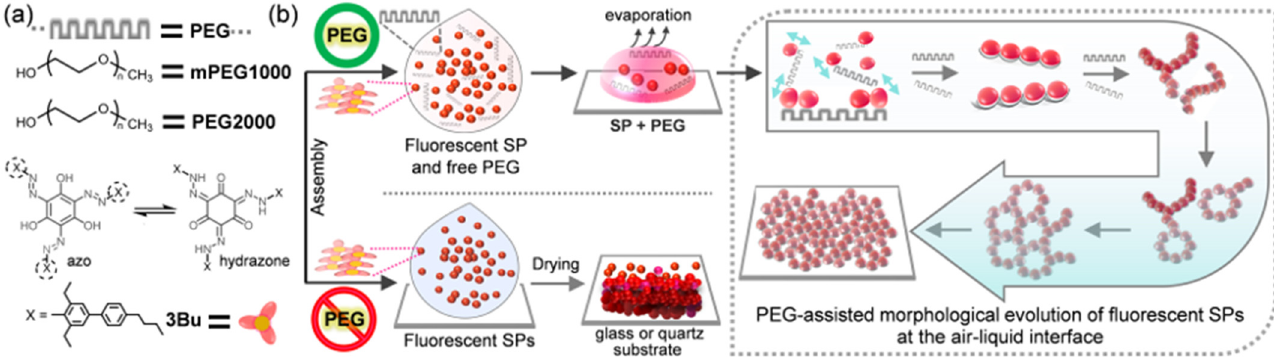
Figure 1. ( a ) Chemical structures. ( b ) Schematic representation of PEG-assisted morphological evolution of fluorescent spherical particles (SPs) into diverse micro- and macrostructures via solvent evaporation. Without PEG chains, Bu SPs were heaped up to form random mounds instead of interconnected networks and flat sheet structures.